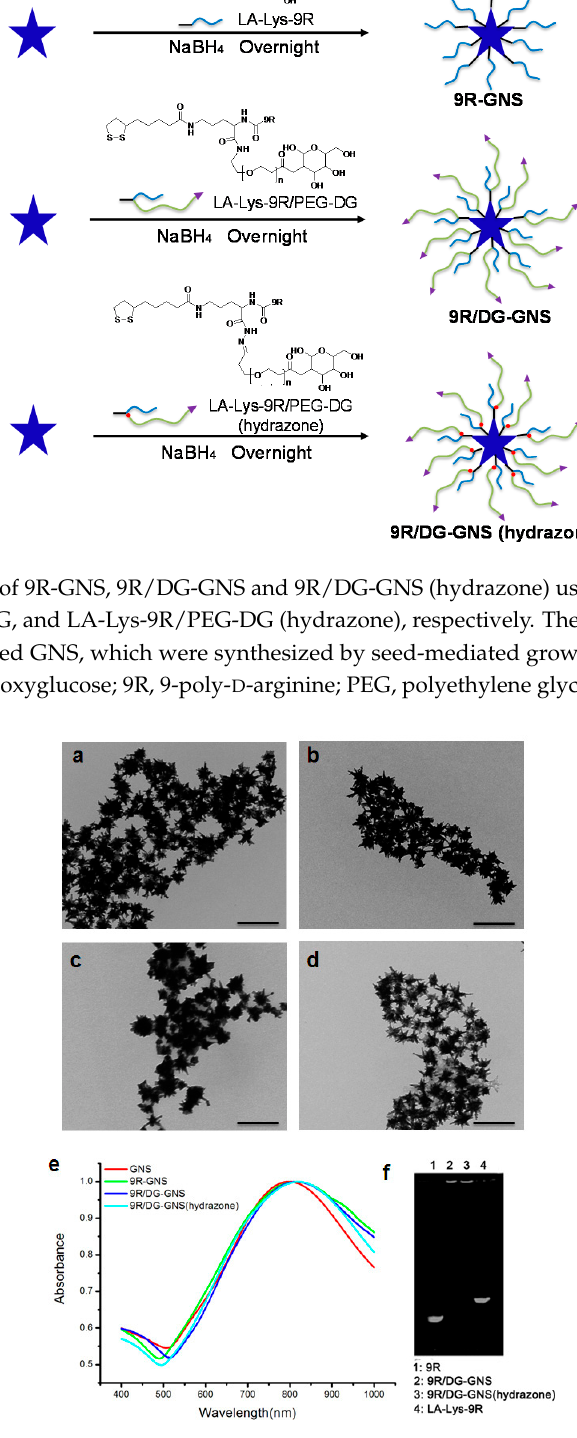
Figure 2. TEM images of GNS: ( a ), 9R-GNS ( b ), 9R/DG-GNS ( c ) and 9R/DG-GNS (hydrazone) ( d ). Scale bar: 200 nm; ( e ) UV-VIS-NIR absorption spectra of GNS, 9R-GNS, 9R/DG-GNS, and 9R/DG-GNS (hydrazone); and ( f ) The sodium dodecyl sulfate polyacrylamide gel electropheresis (SDS-PAGE) of 9R, 9R/DG-GNS, 9R/DG-GNS (hydrazone), and LA-Lys-9R.